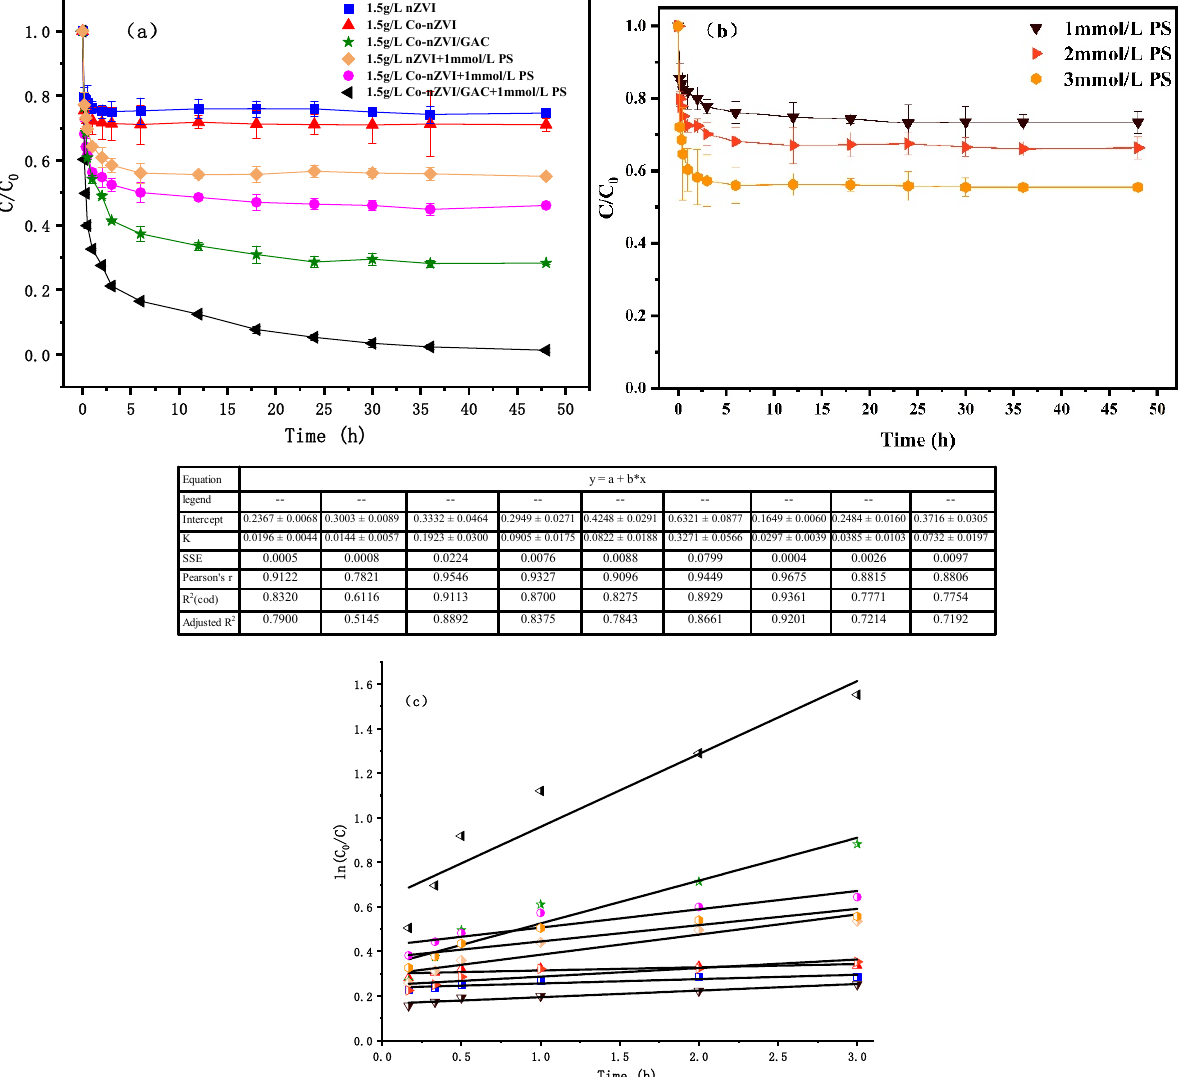
Figure 10. Effects of different systems and linear fitting, ( a ) Degradation curves of PNP by different system materials, ( b ), Dynamic fitting curve ( c ).